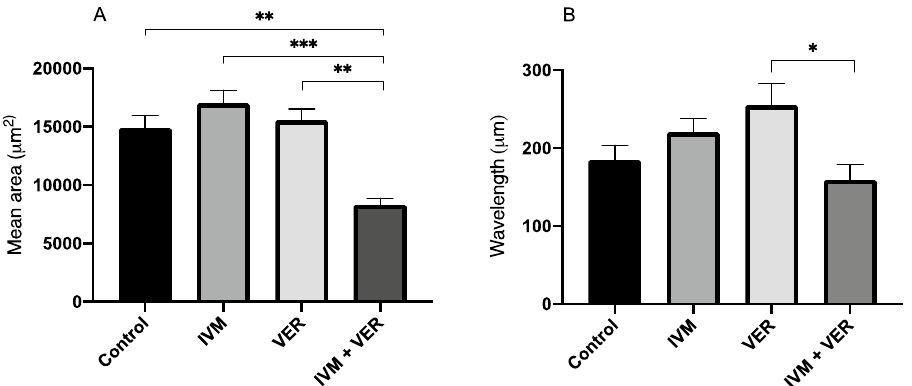
Figure 1. Ivermectin-induced paralysis of larvae is only observed following P-gp inhibition. Bars represent ( A ) mean area occupied or ( B ) mean wavelength ± SE of larvae following exposure to ivermectin with or without verapamil. (Asterisks indicate groups that are significantly different, *** p < 0.001, ** p < 0.01, * p < 0.05).